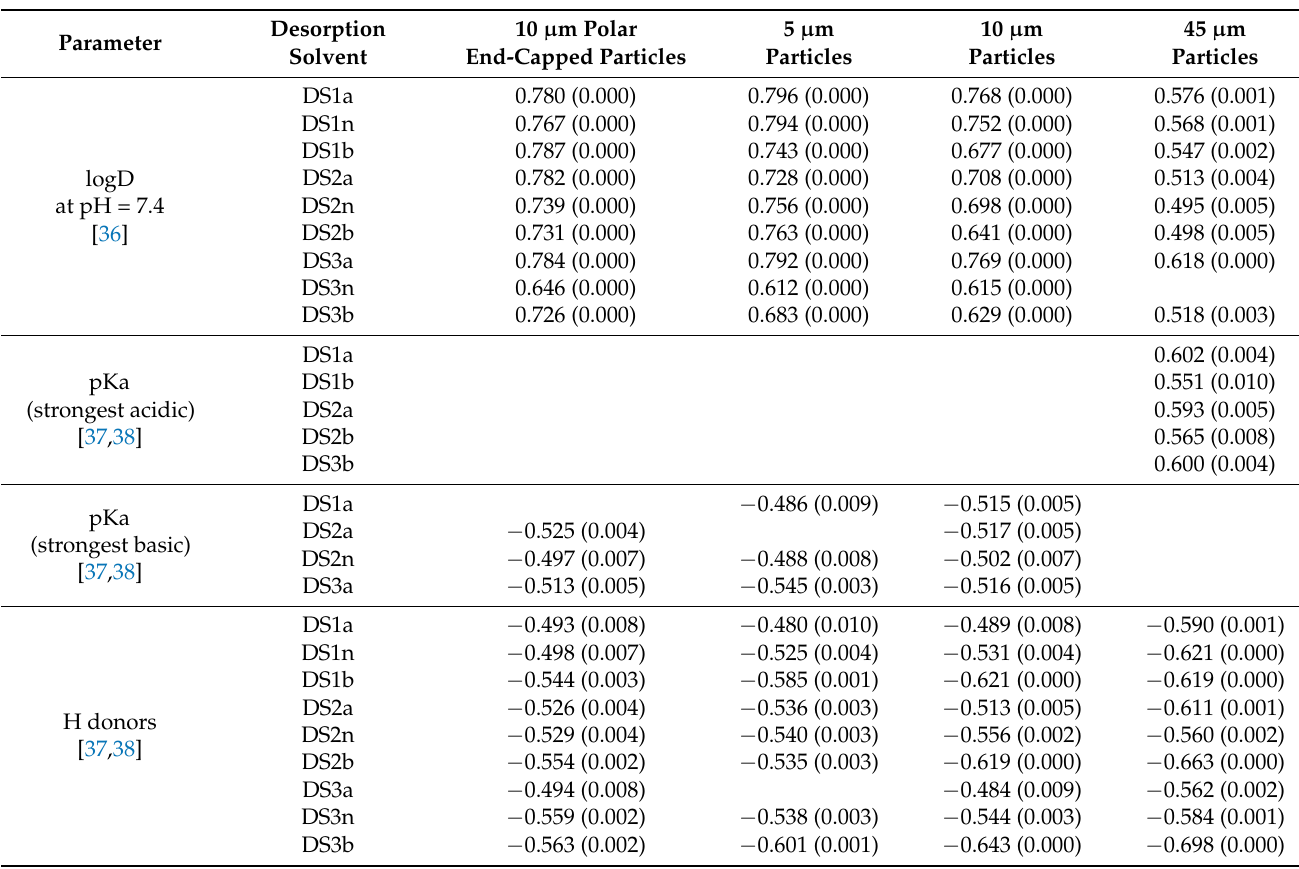
Table 3. Two-way significant correlations [Pearson’s r values] discussed in Section 2.4. p Values given in